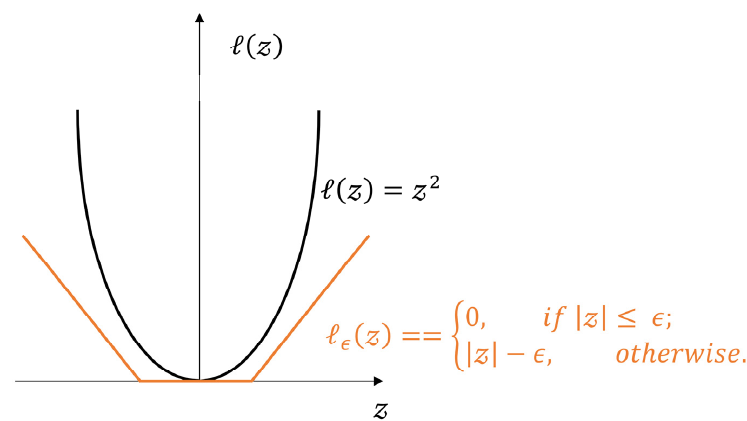
Figure 11. Sketch diagram for the 𝜖 -insensitive loss function.